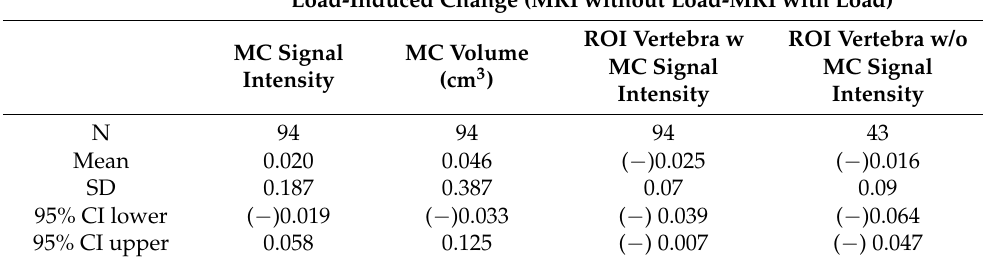
Table 2. Change in Modic signal intensity and Modic volume between magnetic resonance imaging performed with and without spinal loading.